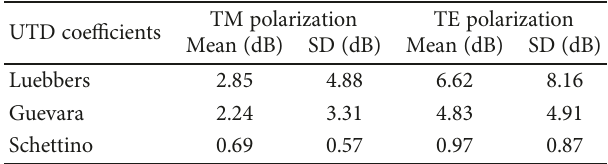
Figure 8: Attenuation of the di ff racted fi eld for TE polarization around the wedge; n -face incidence at ϕ i = 4 π /3 . Table 3: Statistics for n -face